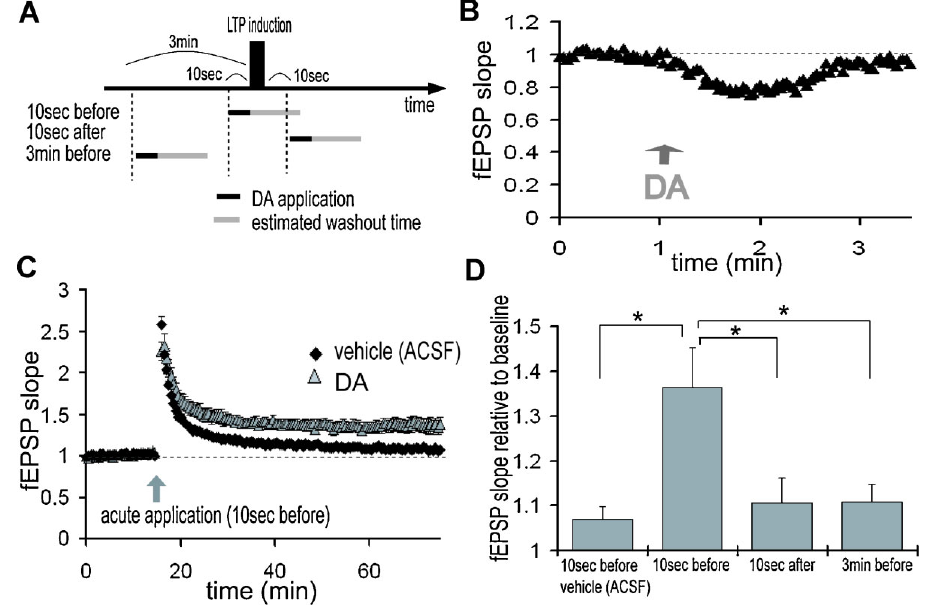
Figure 8. Temporally selectivity of LTP enhancement by DA. ( A ) Acute application of DA. DA was applied for just 10second either 10second before, 10second after, or 3minute before LTP induction. LTP induction protocol was 100Hz 100pulse stimulation, repeated 2 times at an interval of 30second. DA was directly applied in the recording chamber for 10second and estimated washout time was about 1–2minute. ( B ) fEPSP slopes during acute application of DA. TA pathway was stimulated at 0.5Hz. DA was directly applied into the recording chamber at 1minute (indicated by arrow) and its effects on synaptic transmission were reversible. ( C ) DA application at 10second before LTP induction significantly enhanced LTP at TA- CA1 synapses (vehicle: n = 7, DA: n = 8). ( D ) DA application 3minute before or 10second after LTP induction did not enhance LTP (bottom, n = 6 for